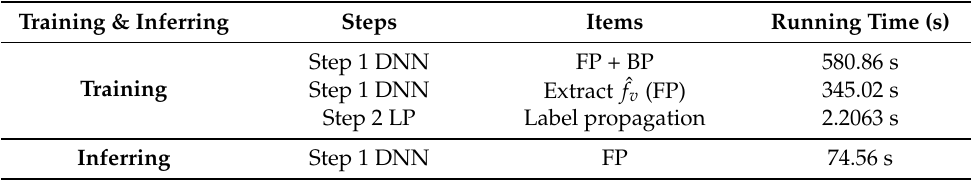
Table 9. The one epoch running time in each step of our method are reported in the table. When training, we used the whole training set of the AVA dataset. When inferring, we used the whole testing set of the AVA dataset. Step 1 DNN means deep neural network pass of step 1. Step 2 LP means label propagation of step 2. The items explain in more detail what is done at each step. FP means forward pass and BP means back propagation.